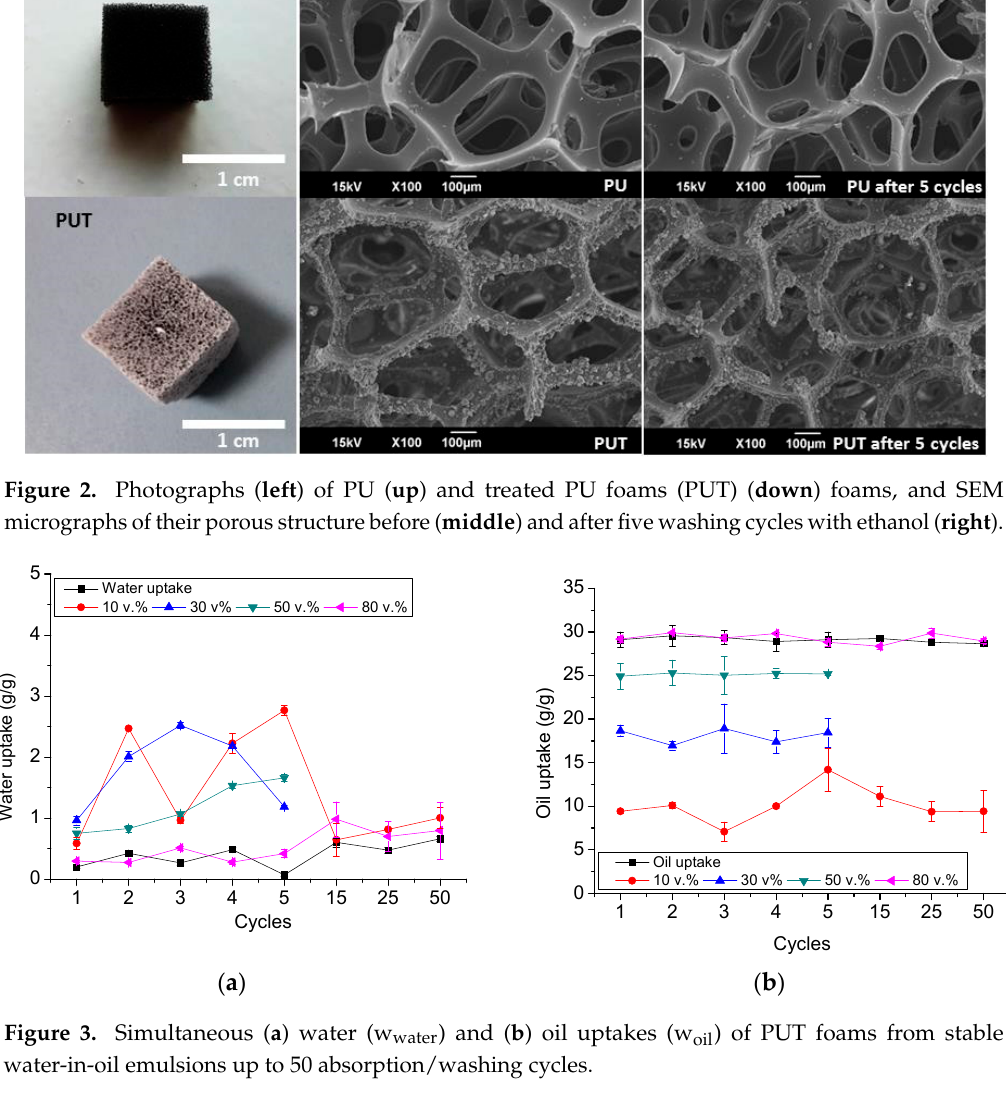
Figure 4. Oil absorption selectivity of PUT foams from stable water-in-oil emulsions up to 50 absorption/washing cycles. Further work was carried out in order to characterize the stability of the treatment of the PUT foams. First, an FITR study was carried out with PUT samples subjected up to 50 washing cycles with ethanol. It was analyzed the evolution of the TPU presence on the surface of the PUT foams as an indicator of the presence of the treatment on these surfaces. The ratio between the PUT foams peaks respectively at about 1078 cm − 1 ( I 1078 , contributed by both the PU and TPU, see Figure 5a) and 1124